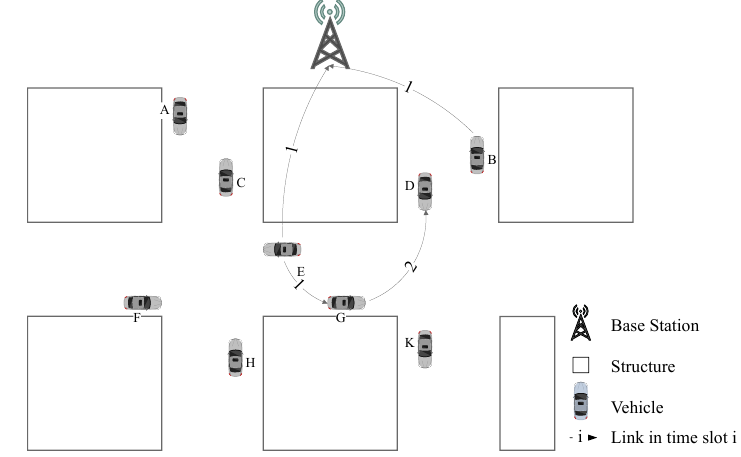
Figure 7. Example of V2I with Assisted